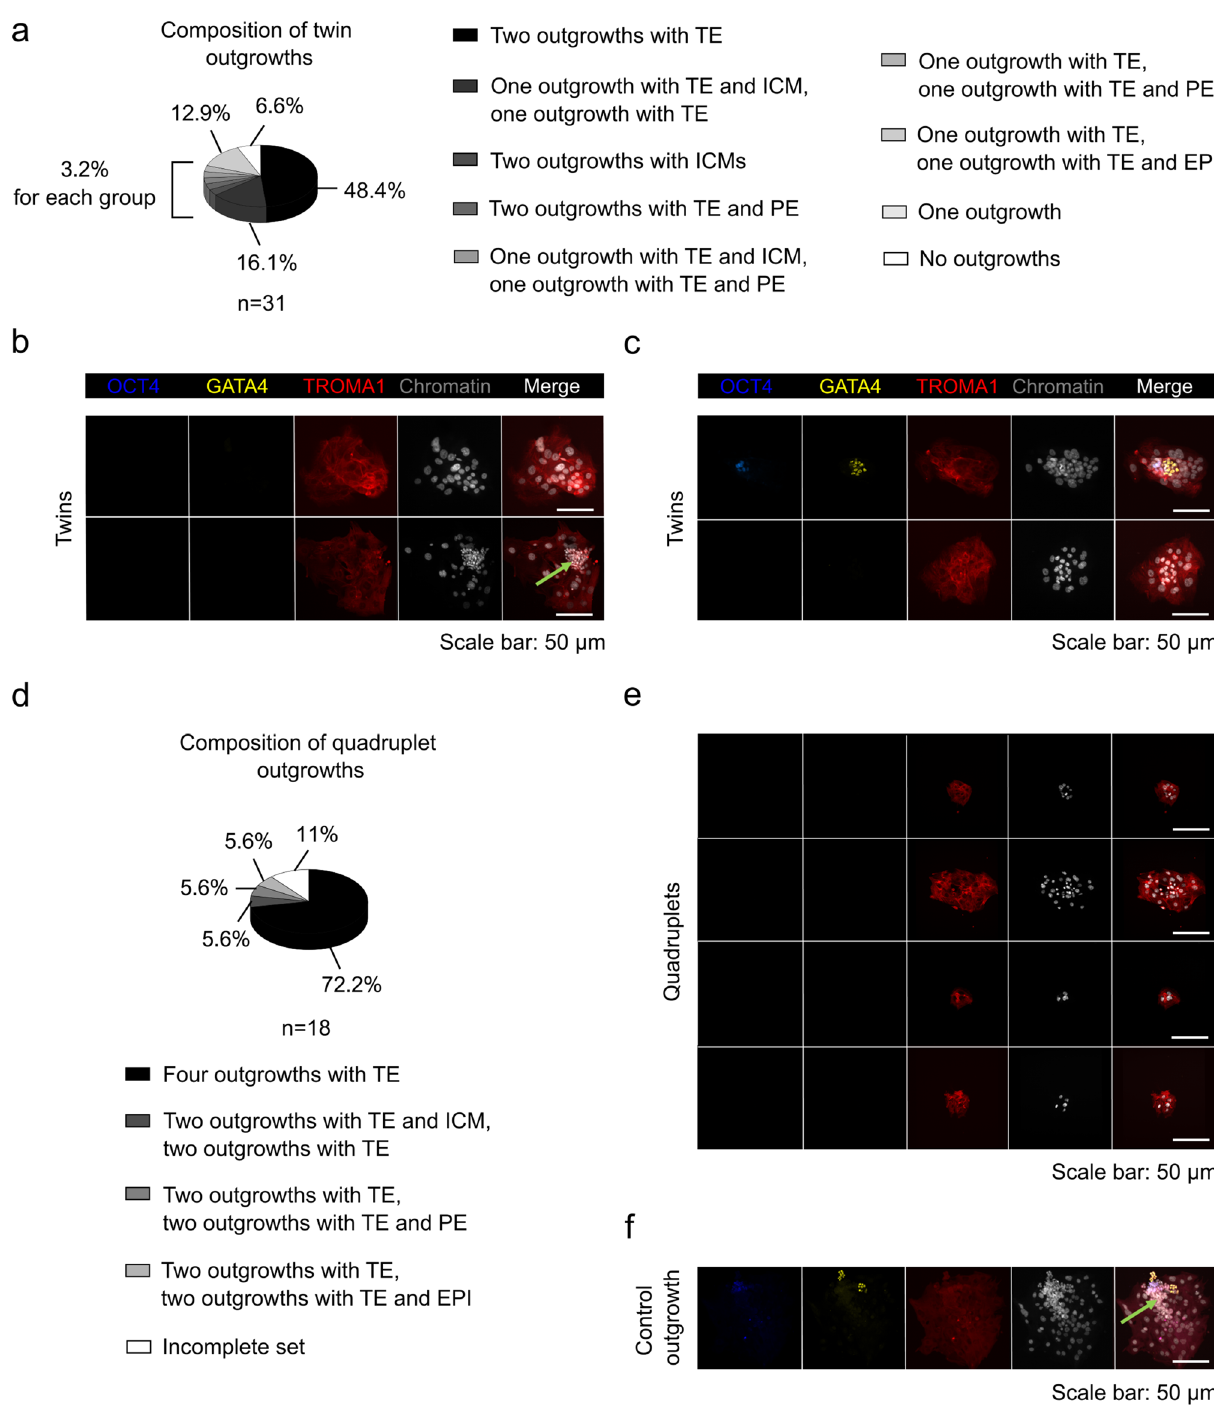
Figure 7. Functional analysis of twin and quadruplet blastocysts. ( a ) Composition of outgrowths derived from 2-cell stage single blastomeres. n indicates the number of twin pairs. ( b ) The expression of OCT4 (blue), GATA4 (yellow), and TROMA1 (red) markers in representative outgrowths developed from two sister blastomeres of a 2-cell embryo. Chromatin (white) was labeled with Hoechst 33342. Scale bar: 50 µm. A pair in which both outgrowths had only TE cells is shown. The green arrow indicates cells negative for both OCT4 and GATA4 markers. A pair in which one outgrowth created TE and ICM derivatives and the other had exclusively TE cells is presented in ( c ). ( d ) Composition of outgrowths derived from 4-cell stage single blastomeres. n indicates the number of quadruplet sets. ( e ) Confocal images of OCT4 (blue), GATA4 (yellow), and TROMA1 (red) expression in representative outgrowths developed from four sister blastomeres of a 4-cell embryo. Chromatin (white) was labeled with Hoechst 33342. Scale bar: 50 µm. A set in which four outgrowths composed of only TE cells is shown. A confocal image of a representative control outgrowth is presented in ( f ). The green arrow indicates cells negative for both OCT4 and GATA4